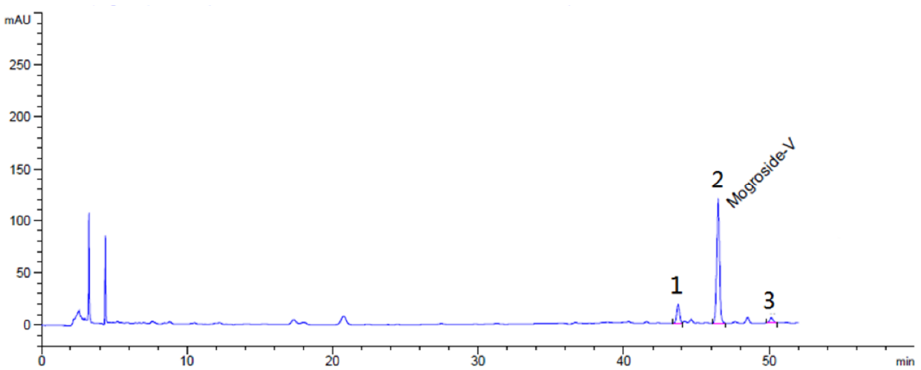
Figure 9. HPLC of Siraitia grosvenorii LH. Peak 1, 11-oxo-mogroside V, 6.8% ( g / g ); peak 2, mogroside